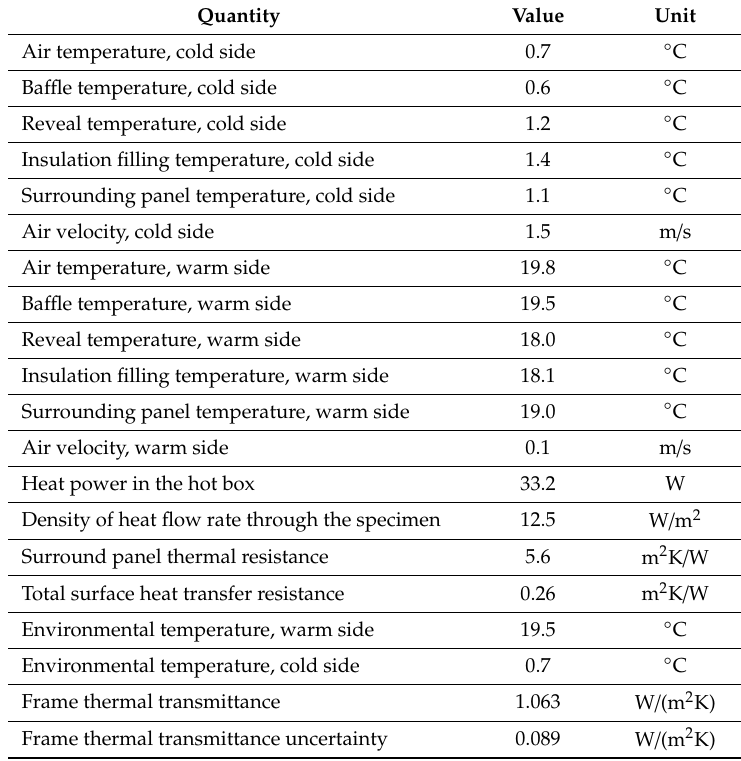
Table 3. Measurement and calculation results of real frame thermal